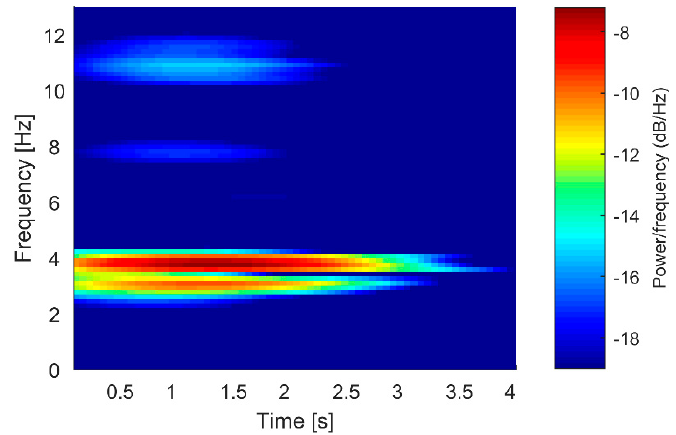
.. z FL av signal.  FL z signal. av